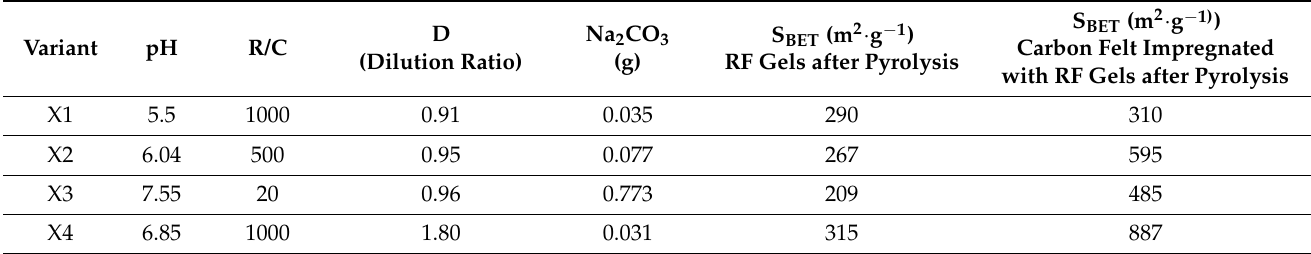
Table 2. The synthesis parameters of carbon xerogels.